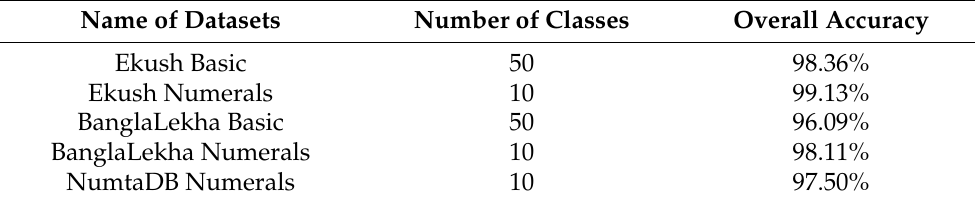
Table 5. Overall Performance of Ekush, BanglaLekha and NumtaDB datasets in terms of overall ac- curacy.